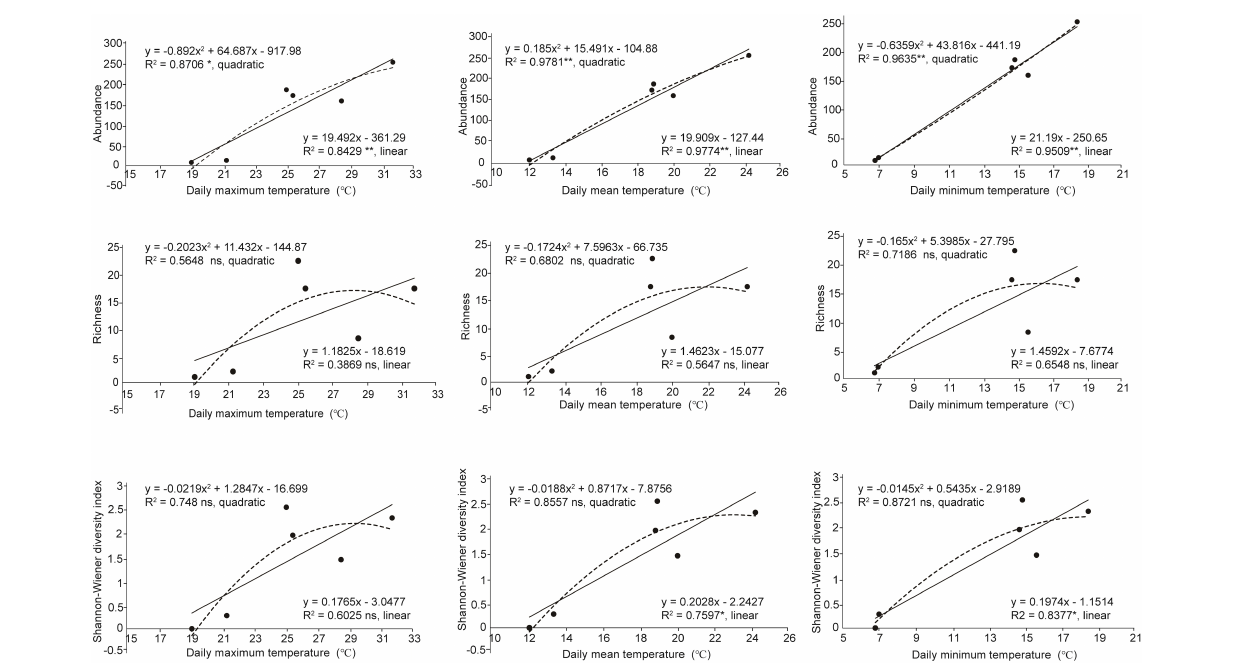
FIGURE 6 | Relationships between temperature and α -diversity of the green lacewing community from six counties (Batang County, Derong County, Litang County, Muli County, Yanyuan County, and Daocheng County). The historical temperature data of the above counties are from China Meteorological Data Service Centre. The linear and quadratic regression were used to fit the temperature pattern. The goodness of fit was assessed based on the adjusted R 2 . **, *, and ns indicate significances at P ≤ 0.01, P ≤ 0.05, and non-significant, respectively. The solid lines indicate linear regression model and the dashed line indicates quadratic